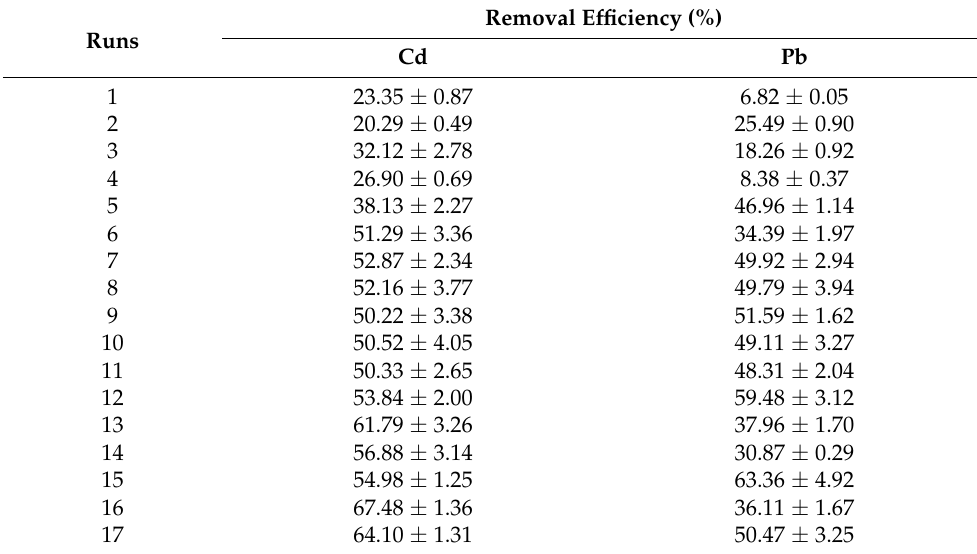
Table 2. Experimental values for removal efficiency using a Box–Behnken design.